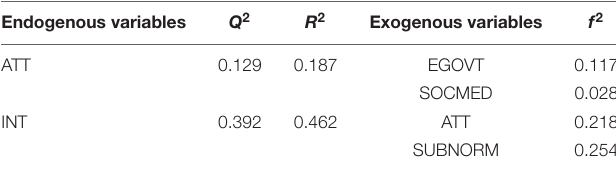
TABLE 5 | Effect size and predictive